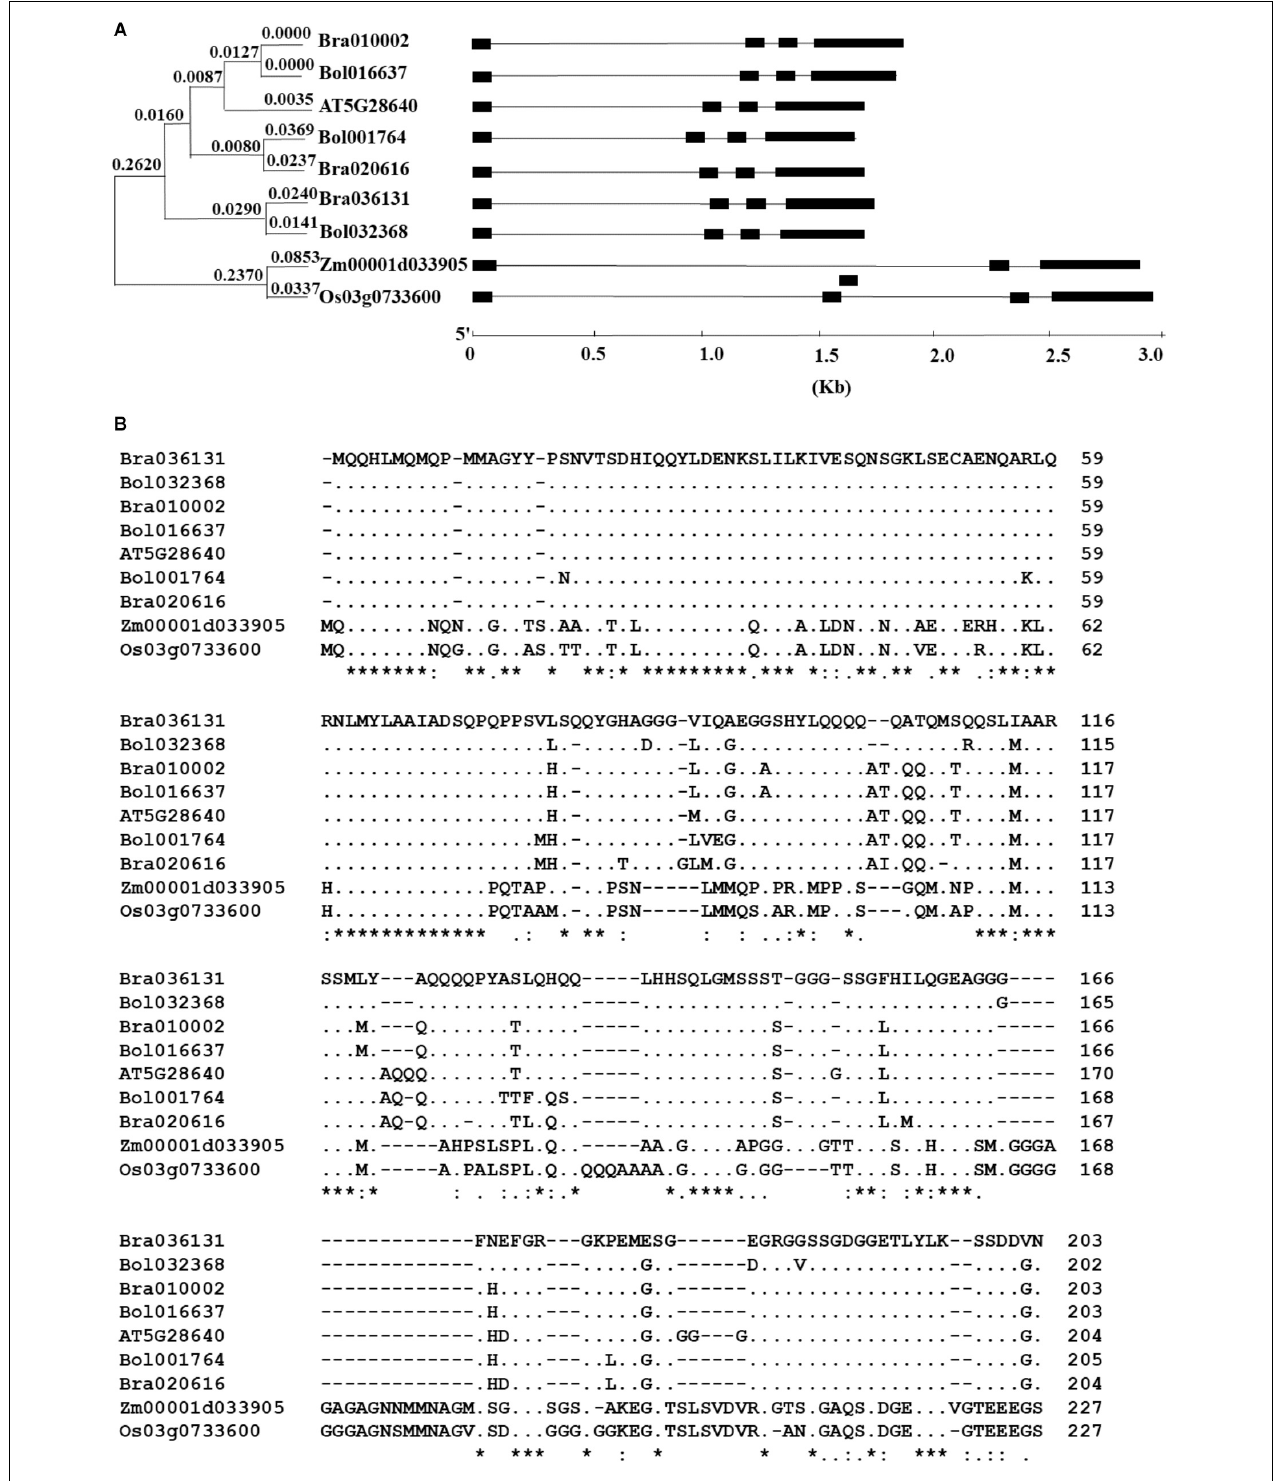
FIGURE 1 | Comparison of the homologs of the AtAN3 protein in Brassica rapa , B. oleracea , Zea mays , and Oryza sativa . (A) Phylogenetic relationship and gene structures of the homologs of the AtAN3 protein in those species. The unrooted phylogenetic tree was generated by the neighbor-joining method using the MEGA5 program with 1,000 bootstraps. Lines represent the introns while solid boxes represent exons. (B) Comparison of the deduced amino acid sequences of the homologs of the AtAN3 protein in those species. Dashes represent gaps, dots represent the identical amino acid residues, and the numbers represent the length of the amino acid